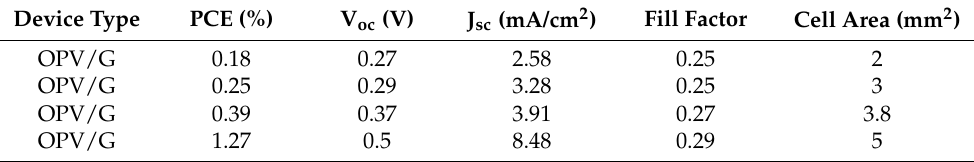
Figure 9. Diagram relationship between PCE of OPVs based on graphene electrodes and scale areas devices. Table 2. J-V analysis of OPV based on graphene electrode at different areas. Device